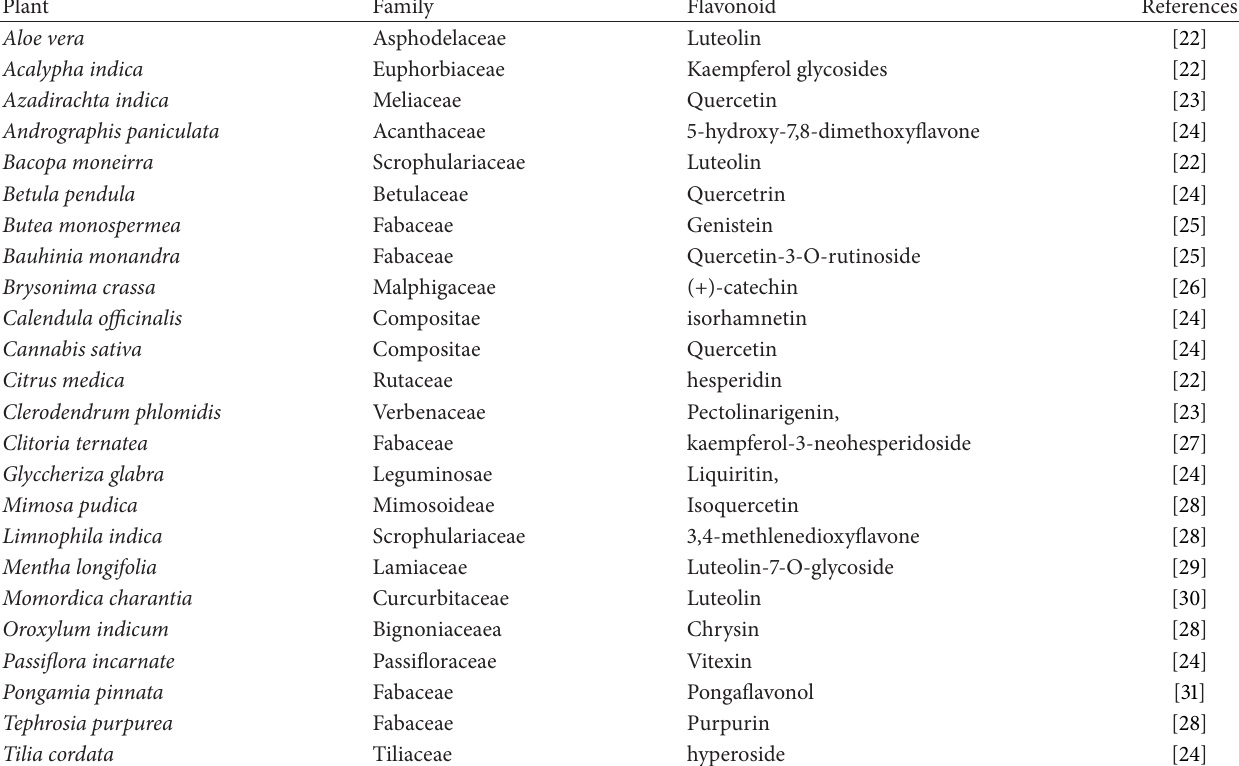
Table 3: Medicinal plants rich in flavonoids